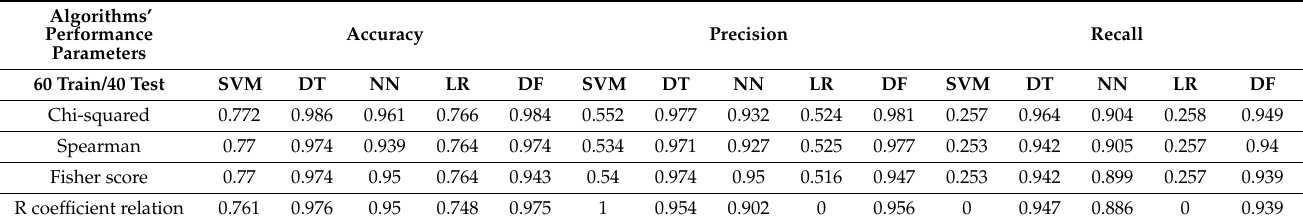
Table 2. Algorithm analysis of accuracy, precision and